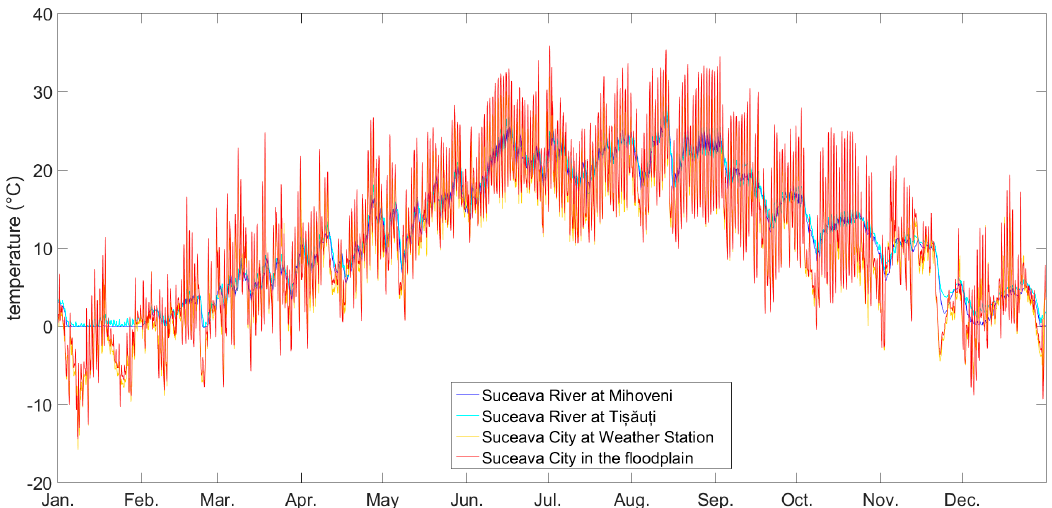
Figure 3. Comparison of water temperature at Mihoveni (upstream) and Ti şă u ţ i (downstream) and air temperature in Suceava city area in 2019 (hourly data).